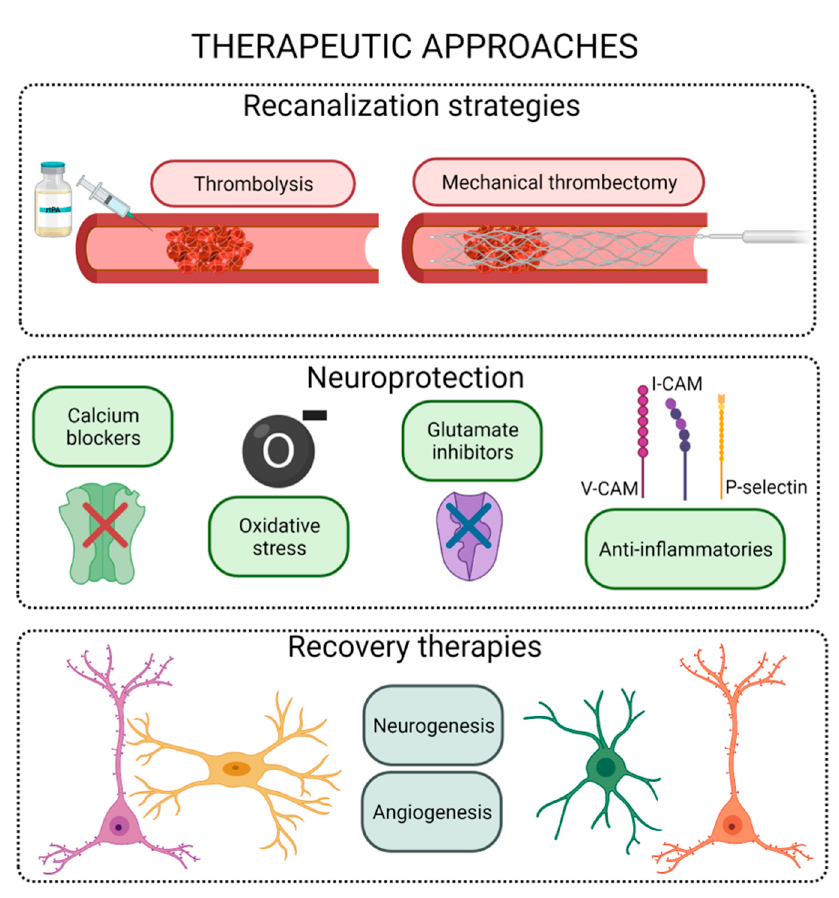
Figure 3. Scheme of the different therapeutic strategies for the ischemic stroke. Figure created with BioRender.com.